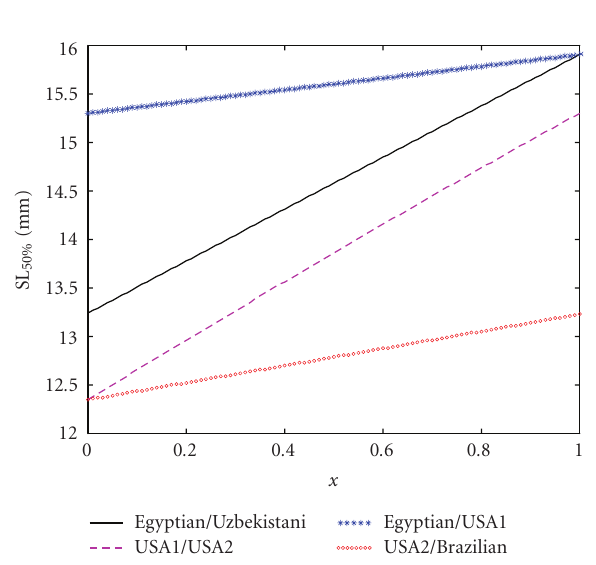
Figure 10: SL 2 . 5% dependence to x